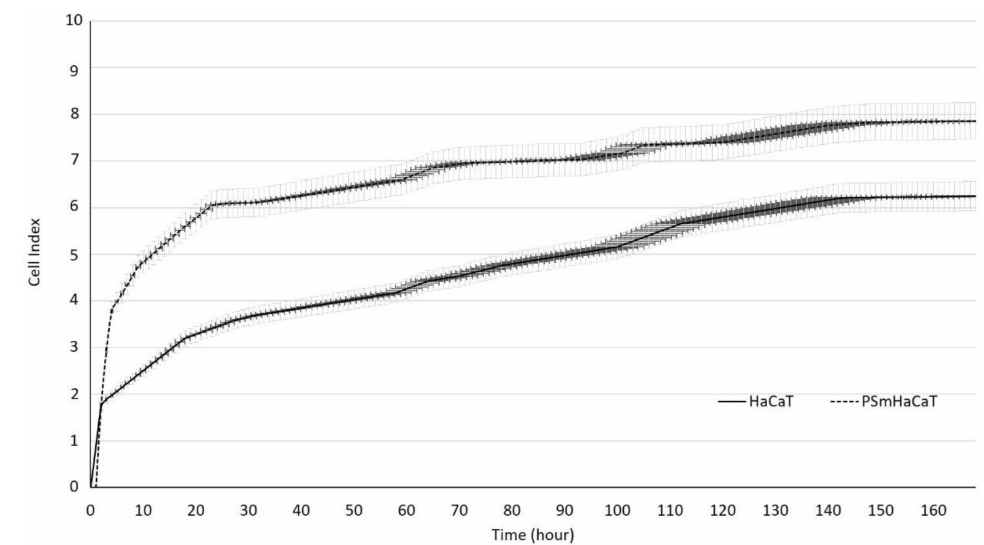
Figure 3. Impedance-based determination of HaCaT cell proliferation. Each data point represents the mean ± SD, n = 10.